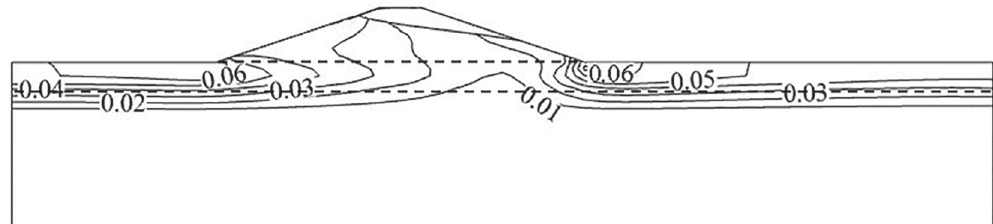
Figure 5: Standard deviation of the hydraulic gradient contour through the embankment.